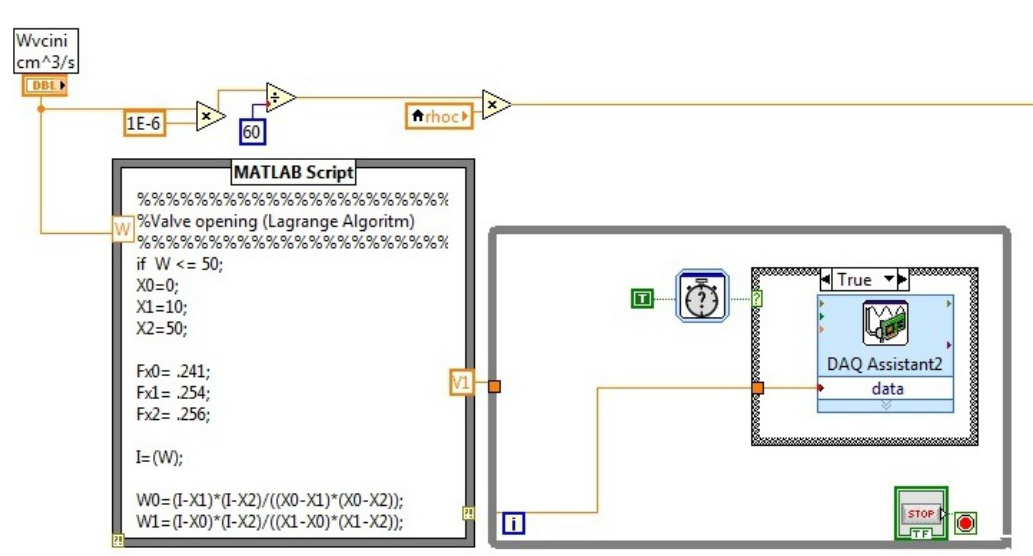
Figure 14. Open loop algorithm.